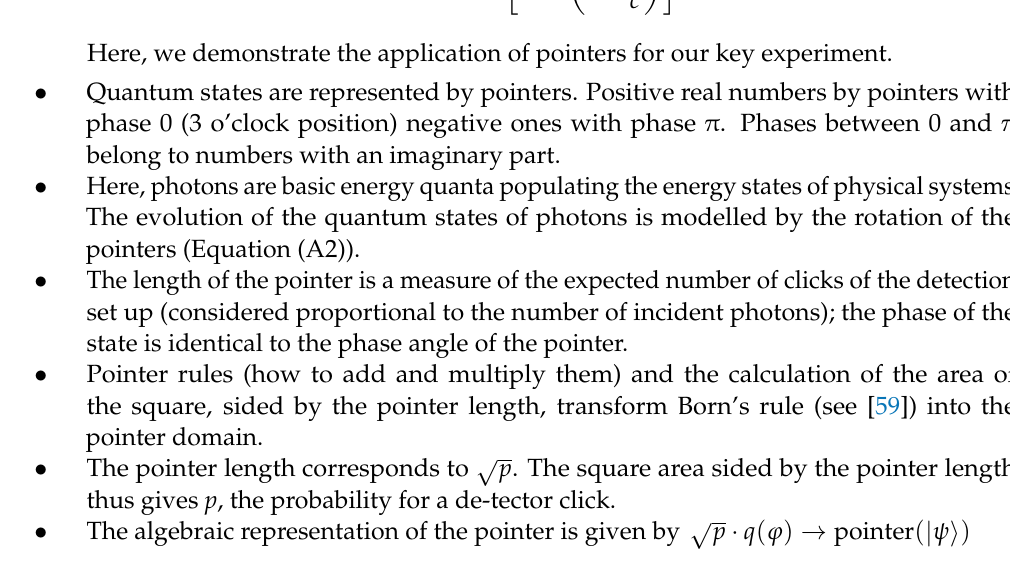
 describes the Fock state at the entrance mode of the 1